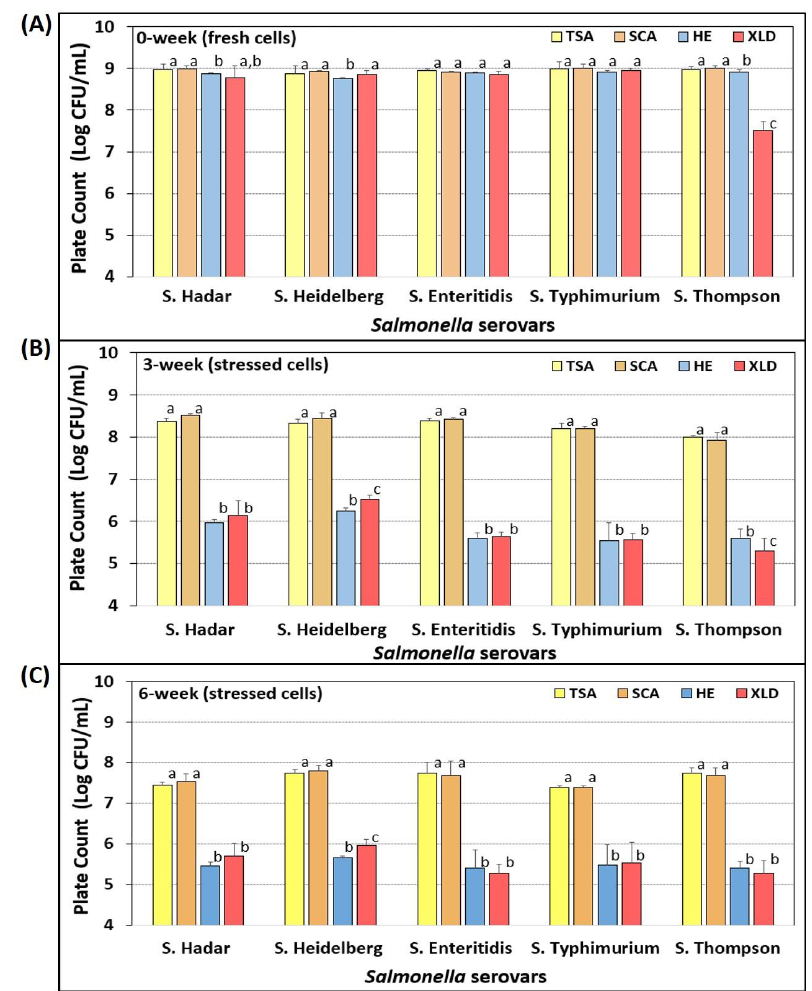
Figure 6. Comparison of four selective media for enumeration of individual Salmonella serovars after extended nutrient starvation for 0-weeks ( A ), 3-weeks ( B ), and 6-weeks ( C ) at 4 ◦ C. Each serovar was plated on TSA, SCA, HE, and XLD containing spectinomycin (5 ug / mL), novobiocin (50 ug / mL), and clindamycin (5 ug / mL). Cultures included S. Thompson 120, S. Heidelberg F5038BG1, S. Hadar MF60404, S. Enteritidis H3527, and S. Typhimurium H3380. Data are presented as the mean of triplicate replications of cultures and their dilutions, and error bars represent the standard deviation from the mean. Within the same serotype, comparisons of means with different letters are significantly different ( p < 0.05) as determined by one-way ANOVA using the Holm–Sidak test for pairwise multiple comparisons; means with the same letter are not significantly different ( p > 0.05).